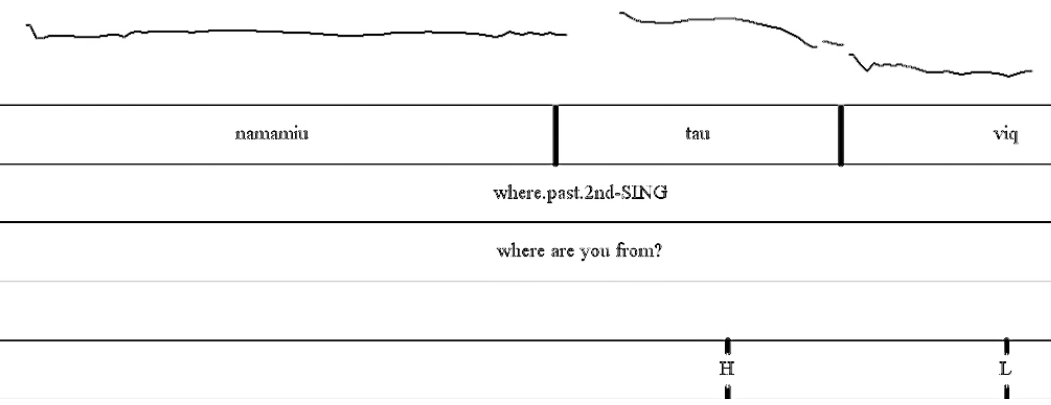
Figure 5. Falling intonation contour produced by a female speaker from Iqaluit (Shokeir 2009, p. 24).